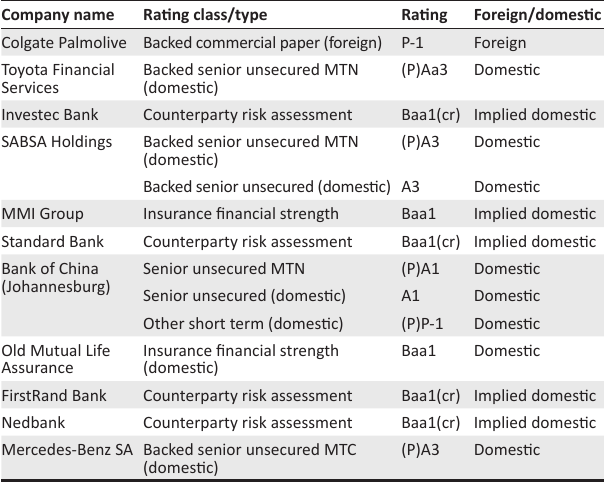
TABLE 1: Moody’s credit ratings piercing the Baa2 level of the sovereign rating (September